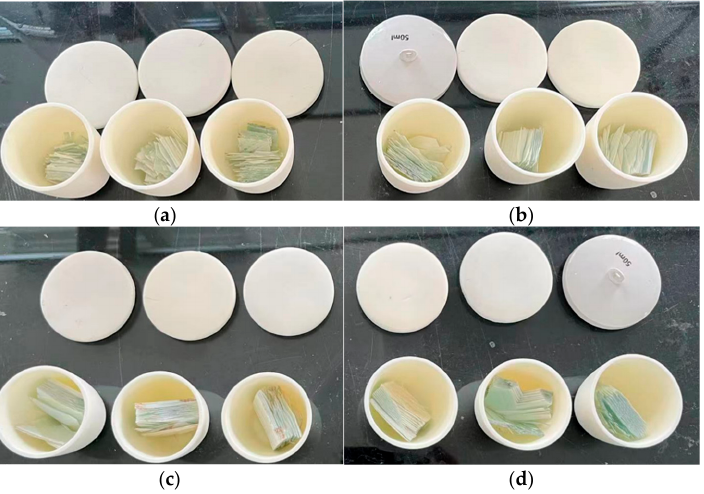
Figure 5. Samples for the loss-on-ignition (LOI) test: ( a ) Plain samples of DN 400; ( b ) Plain samples of DN 500; ( c ) Stiffened samples of DN 400; ( d ) Stiffened samples of DN 500.